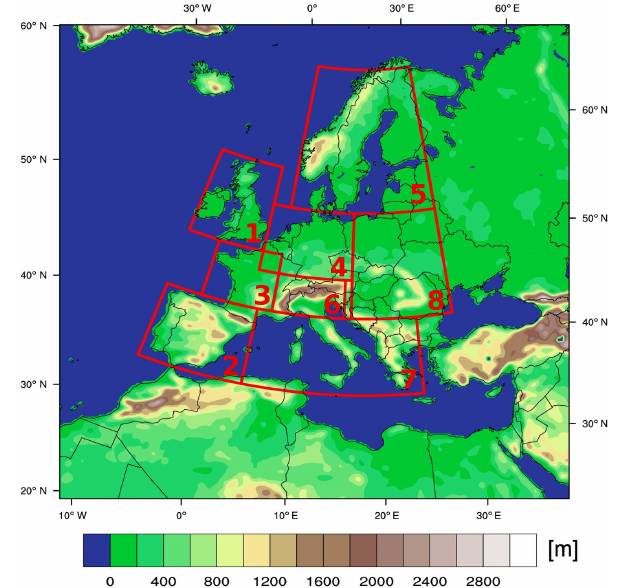
Figure 1. CCLM modelling domain (EURO-CORDEX domain): Model orography and PRUDENCE regions. 1: British Isles, BI; 2: Iberian Peninsula, IP; 3: France, FR; 4: Mid-Europe, ME; 5: Scandinavia, SC; 6: Alps, AL; 7: Mediterranean, MD; and 8: eastern Europe,